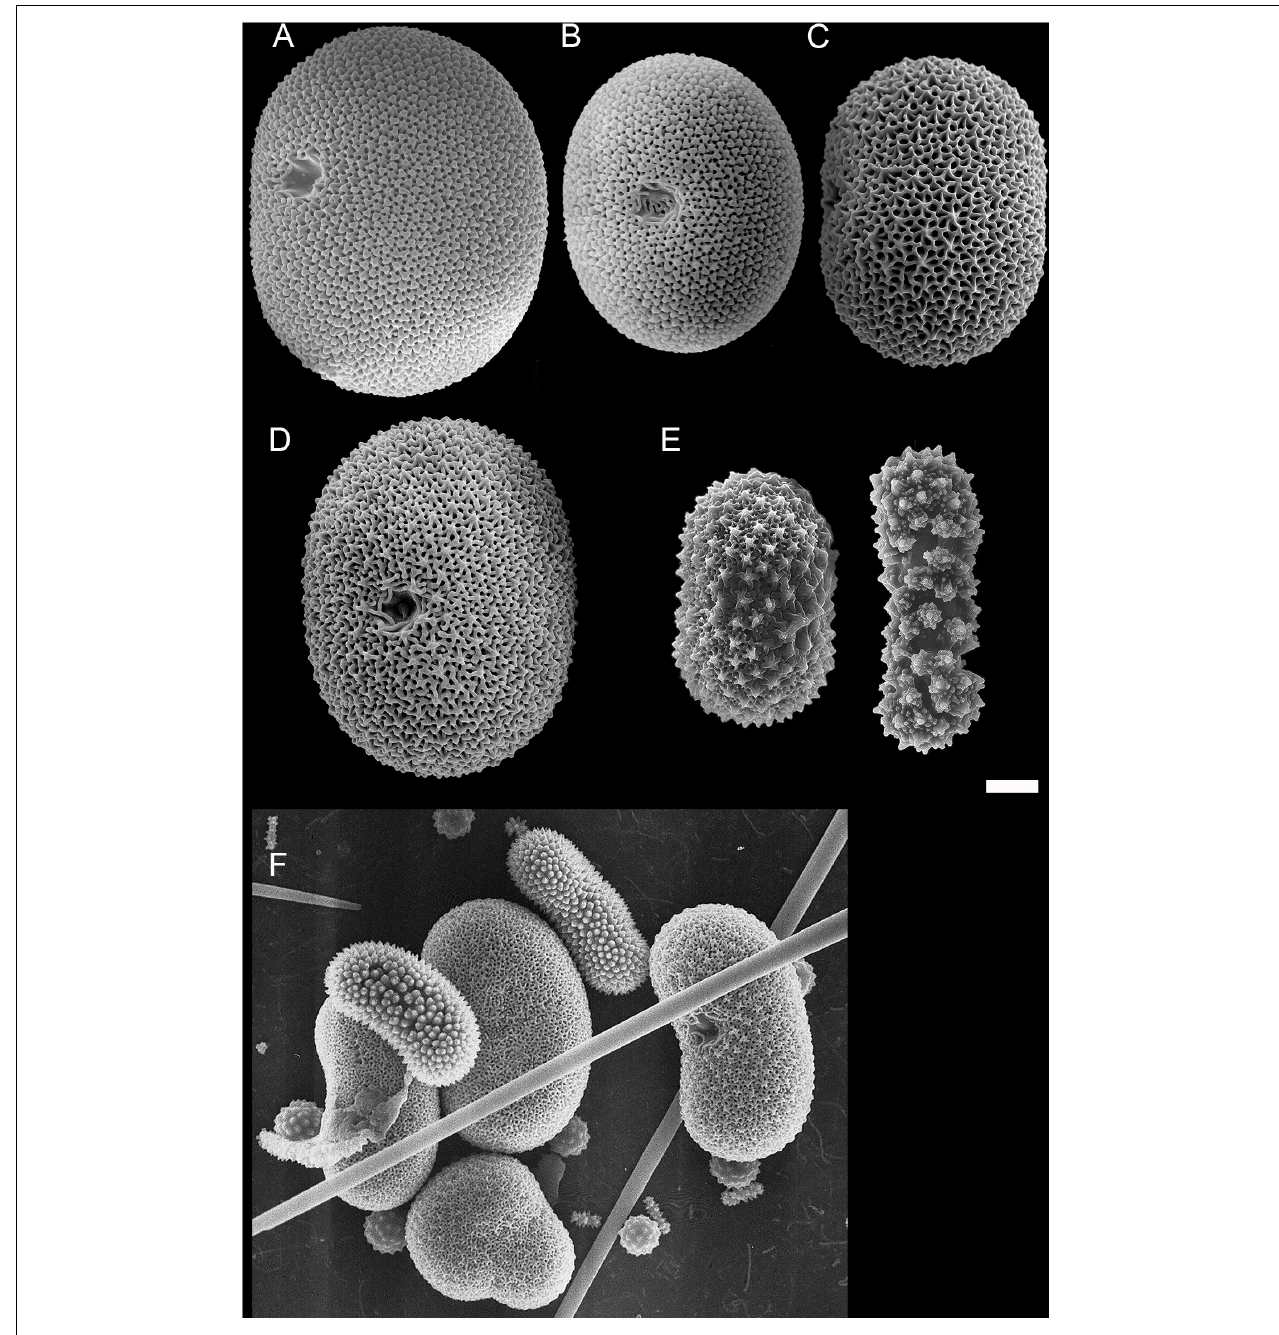
FIGURE 7 | Morphology of selenasters from Placospongia . (A) Selenaster of Placospongia ruetzleri (holotype, RMNH 9872). Picture: R.W.M. van Soest. (B,C) Selenasters of Placospongia caribica (holotype, USNM 32873). Pictures: K. Rützler. (D) . Selenaster of Placospongia melobesioides (Florida, USNM 39643). Picture: K. Rützler. (E) Selenasters of Placospongia sp. (Fernando de Noronha, Brasil, MNRJ 7878). Picture. F. Moraes. (F) Selenasters of Placospongia decorticans (Ras El Chakaa, cave, Lebanon, Endoume collection). This is a mix of late-stage and early-stage selenasters (smaller). Picture: S. Carteron. Scale A–D, F: 10 µ m. Scale E: 50 µ